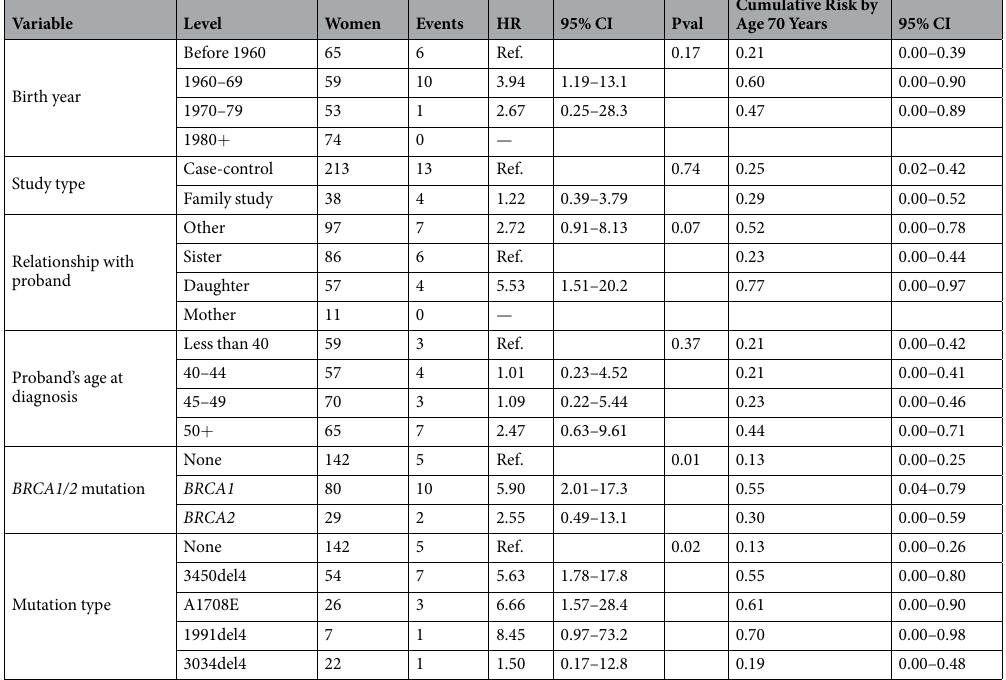
Table 5. Estimated hazard ratios (HRs) of breast cancer in relatives of carriers of Colombian BRCA1/2 founder mutations stratified by birth year, proband’s age at diagnosis, mutated BRCA1/2 gene and BRCA1/2 mutation type. HR, hazard ratio; CI, confidence interval; Pval, P-value; Ref.,